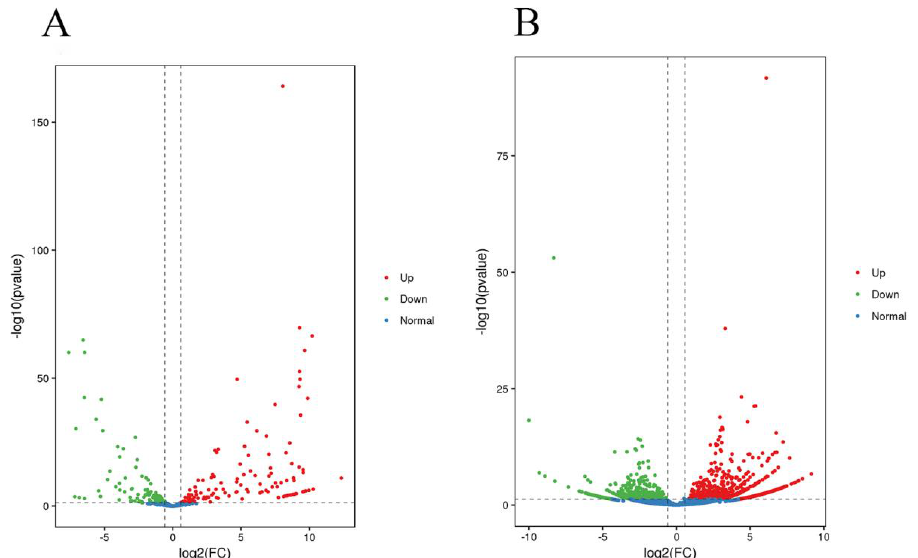
Figure 2. Differential microRNA ( A ) and circRNA ( B ) expression between testis and caput epididymis. Volcano plots showing − log 10 ( p -value) versus log 2 (fold change) in RPM. Red dots denote significantly upregulated microRNAs and circRNAs, whereas green dots denote significantly downregulated microRNAs and circRNAs.